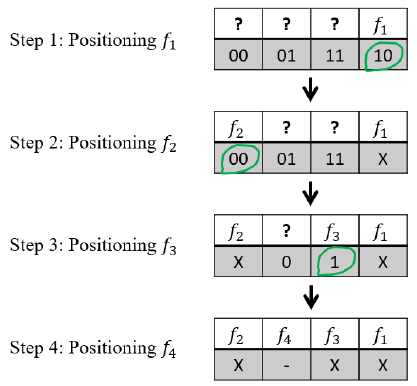
Figure 2. An example of PSC application to generate key from a subgroup with four elements.